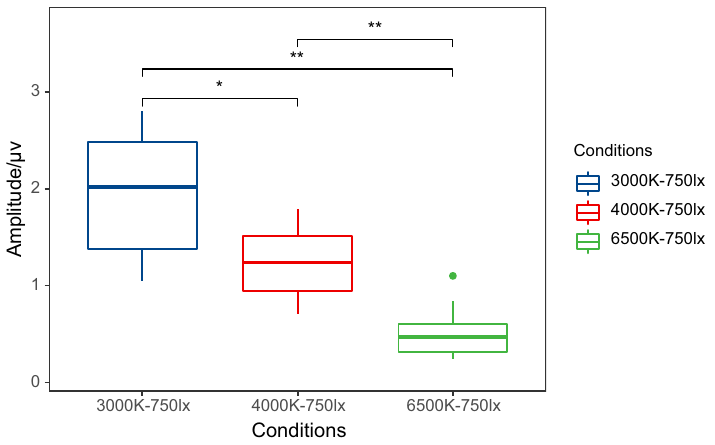
Figure 3. An example of P3b amplitudes with different colour temperatures under 750 lx illuminance at the CP4 electrode (*P < 0.05; **P < 0.01). The amplitude at 3000 K was significantly higher, indicating that the lowest mental workload occurred at 3000 K.